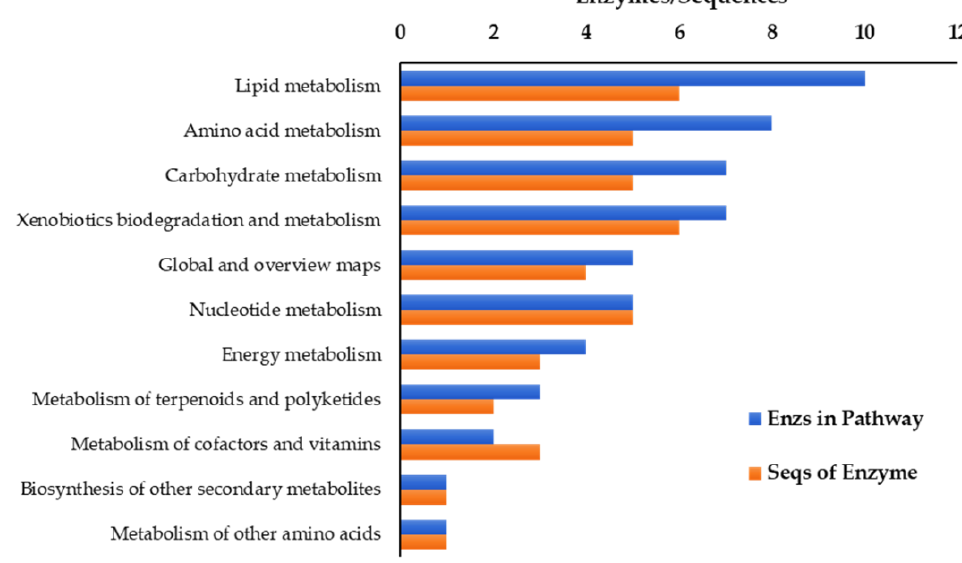
Figure 3. KEGG pathway analysis of drought Figure 3 . KEGG pathway analysis of drought tolerance .